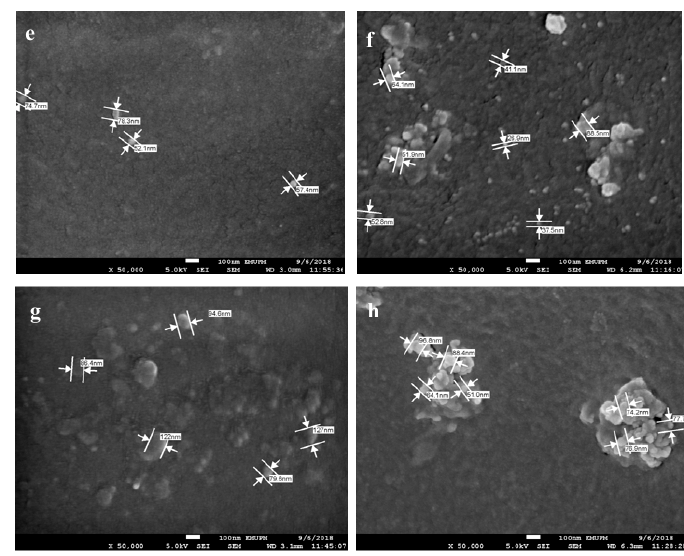
Figure 10. AgNPs’ and SPNCCs’ size: ( a ) core surface, 1 wt%; ( b ) surface, 1 wt%; ( c ) core surface, 2 wt%; ( d ) surface, 2 wt%; ( e ) core surface, 3 wt%; ( f ) surface, 3 wt%; ( g ) core surface, 4 wt%; ( h ) surface, 4 wt%.